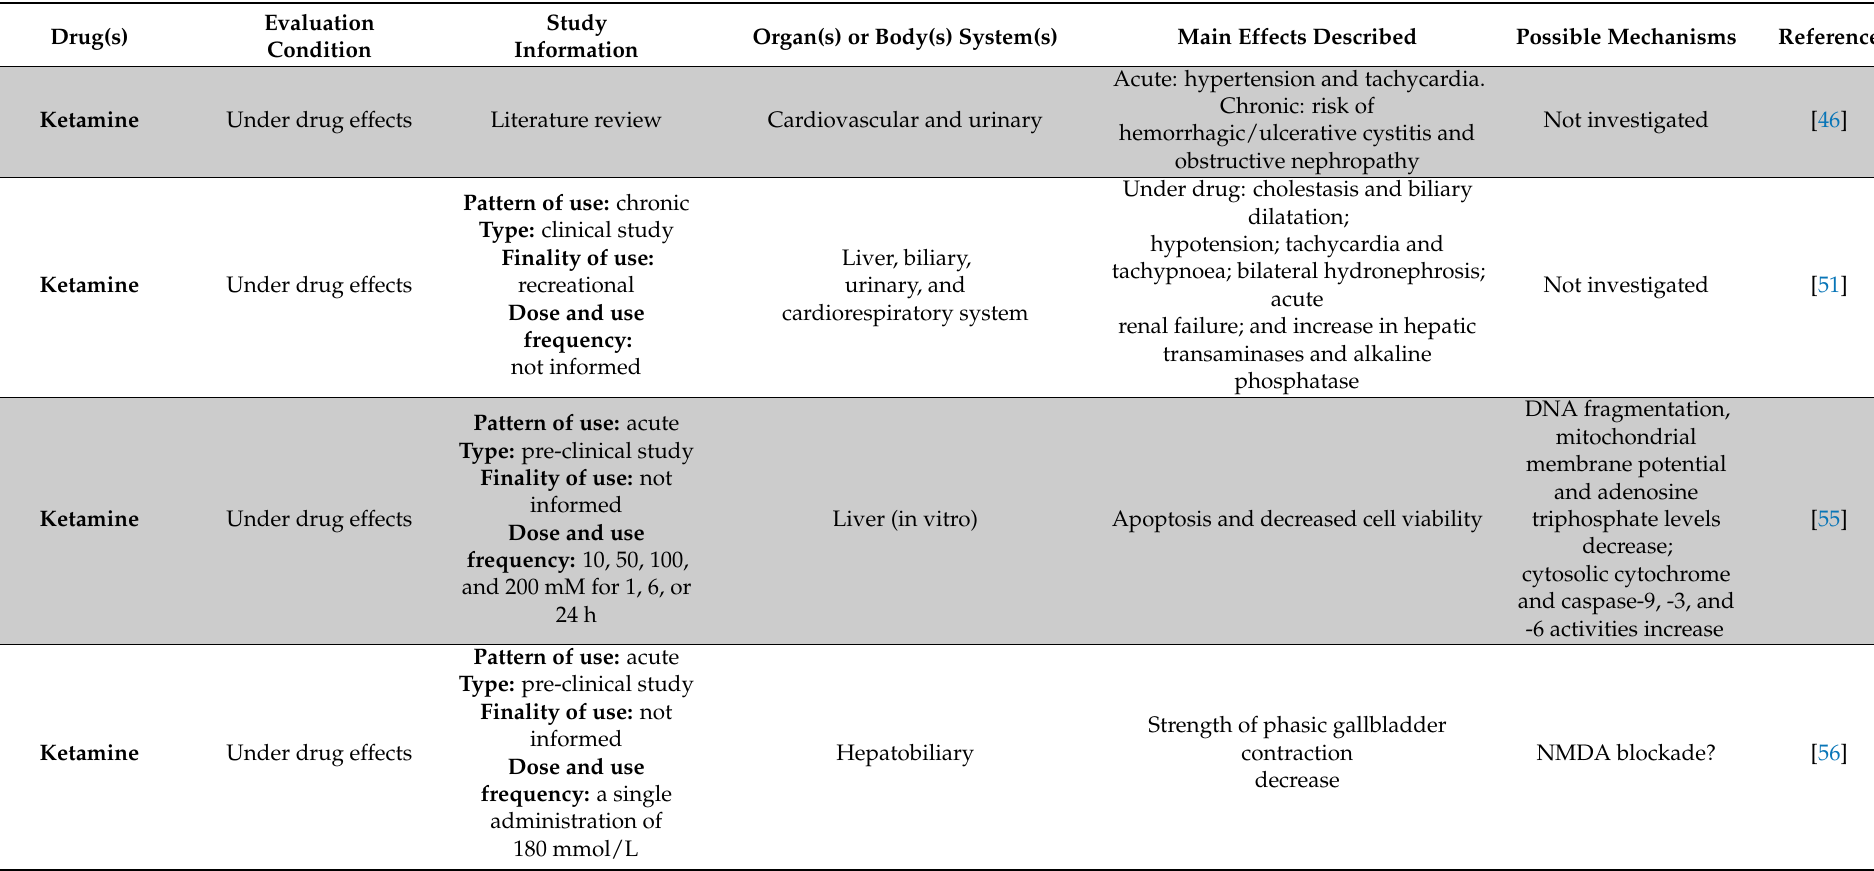
Table 1. Effects reported in studies about ketamine and ethanol solely or combined on cardiovascular, respiratory, urinary, and hepatobiliary systems.